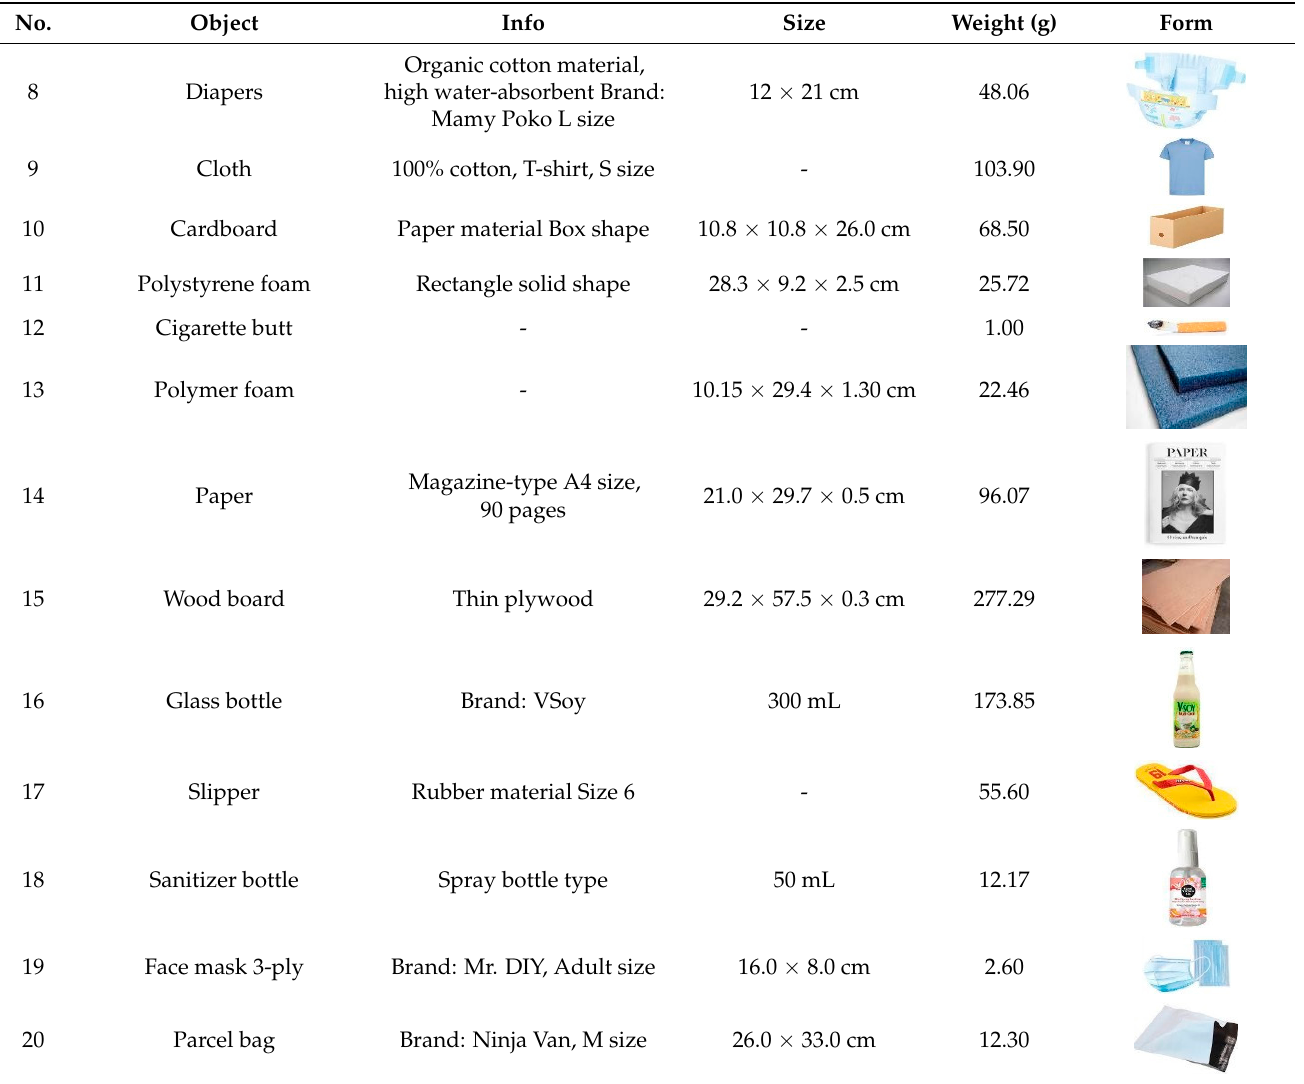
Figure 2. Water displacement method. Source: Author. The volume of non-geometric FL was calculated using Equation (2): Vo = V1 − Vm